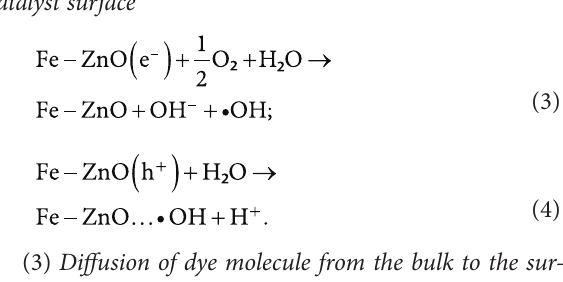
Figure 4. Fitting of dark reaction data in Langmuir adsorption isotherm